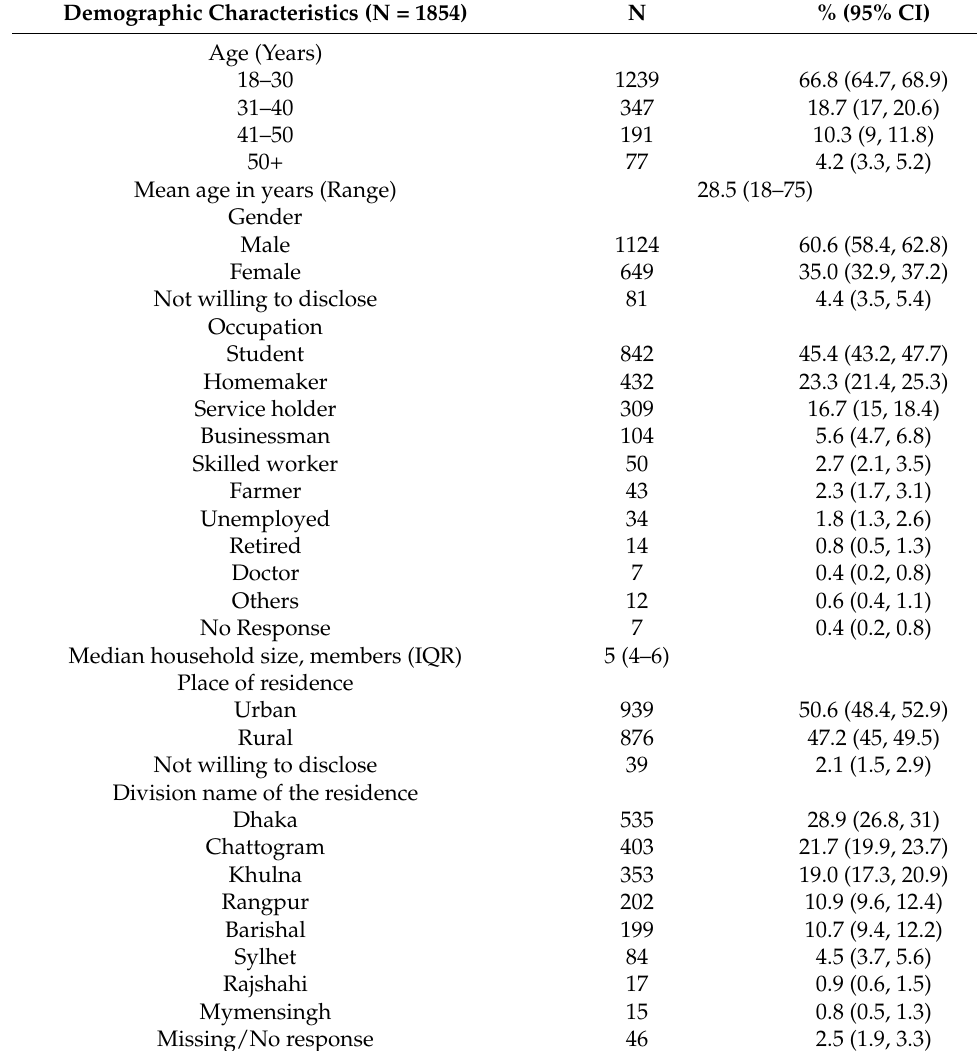
Table 1. Demographic characteristics of the participants of mobile phone survey during the COVID- 19 pandemic from January 2021 to March 2021 in Bangladesh. Demographic Characteristics (N =